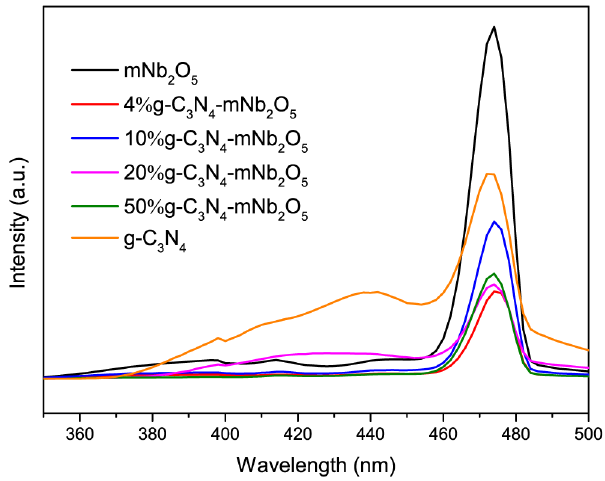
Figure 7. PL spectra of mNb 2 O 5 , 4% g-C 3 N 4 -mNb 2 O 5 , 10% g-C 3 N 4 -mNb 2 O 5 , 20% g-C 3 N 4 -mNb 2 O 5 , 50% g-C 3 N 4 -mNb 2 O 5 and g-C 3 N 4 .